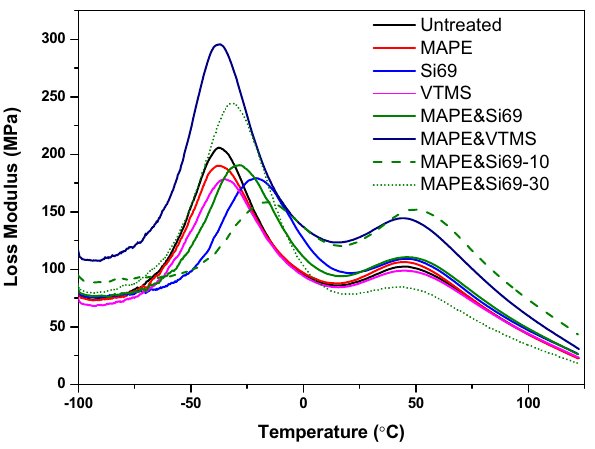
Figure 6: tan δ of untreated and coupling agent treated RubWPC as a function